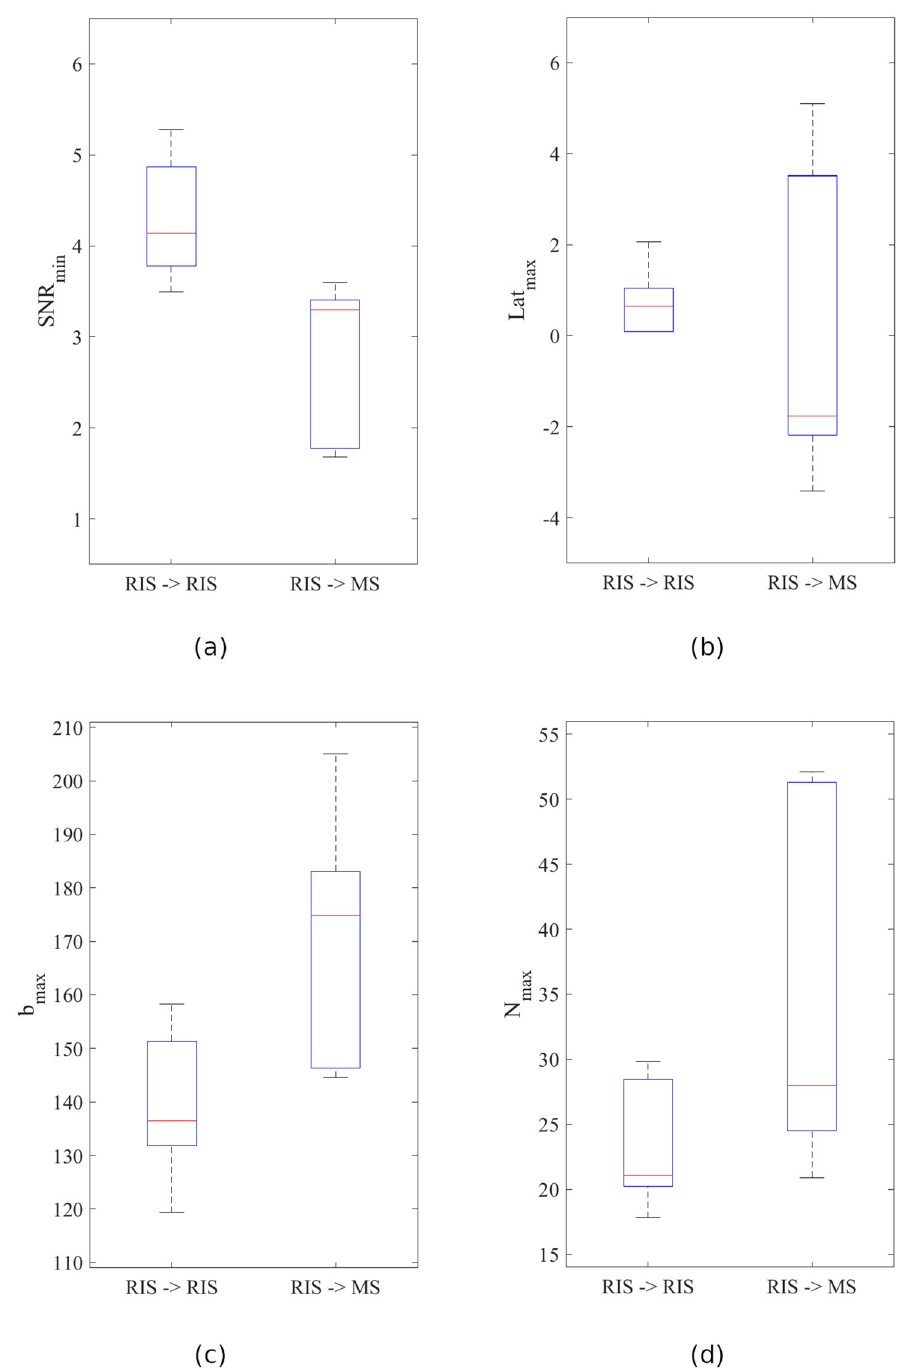
Figure 3. Boxplot of variables included in the study: ( a ) SNR min variable, ( b ) Lat max variable, ( c ) b max variable, ( d ) N max variable. These images were generated using Matlab (Version: R2018b, Url: https ://www.mathw orks. com/produ cts/matla